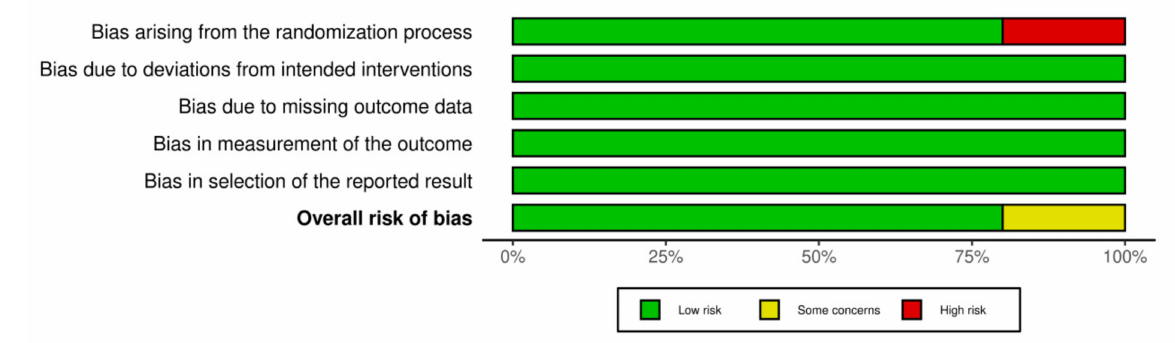
Figure 3. Illustrating the overall risk of bias from the included